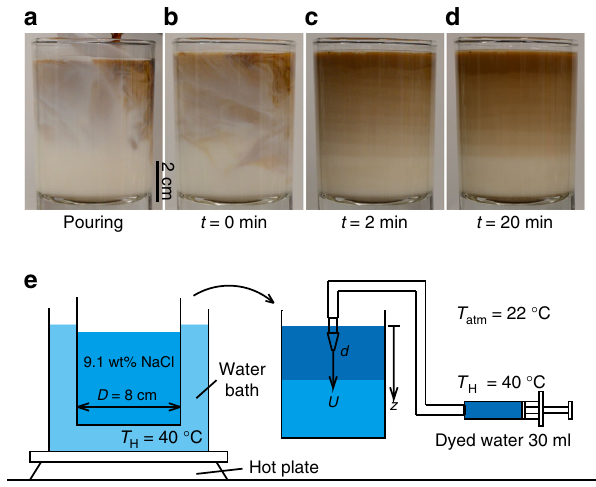
Fig. 1 Pattern formation in an injection-driven system inspired by a layered latte. a – d Formation of horizontal layers in a glass of latte. a A small volume ( V I ¼ 30 ml) of espresso (temperature T H ¼ 50 (cid:3) C ) is poured into 150 ml of warm milk ( T H ¼ 50 (cid:3) C ). b Espresso and milk form a mixture, which exhibits chaotic dynamics caused by the injection. The resulting espresso- milk mixture remains at the top of the container due to buoyancy. c As the mixture cools down to room temperature, T atm ¼ 22 (cid:3) C , multiple horizontal layers of different espresso concentrations are formed. d These horizontal layers maintain their structures over time (see Supplementary Movie 1). e Schematic of model experiments. Dyed water (0.01 wt% methylene blue hydrate) and sodium chloride solution (9.1 wt%) are heated in a water